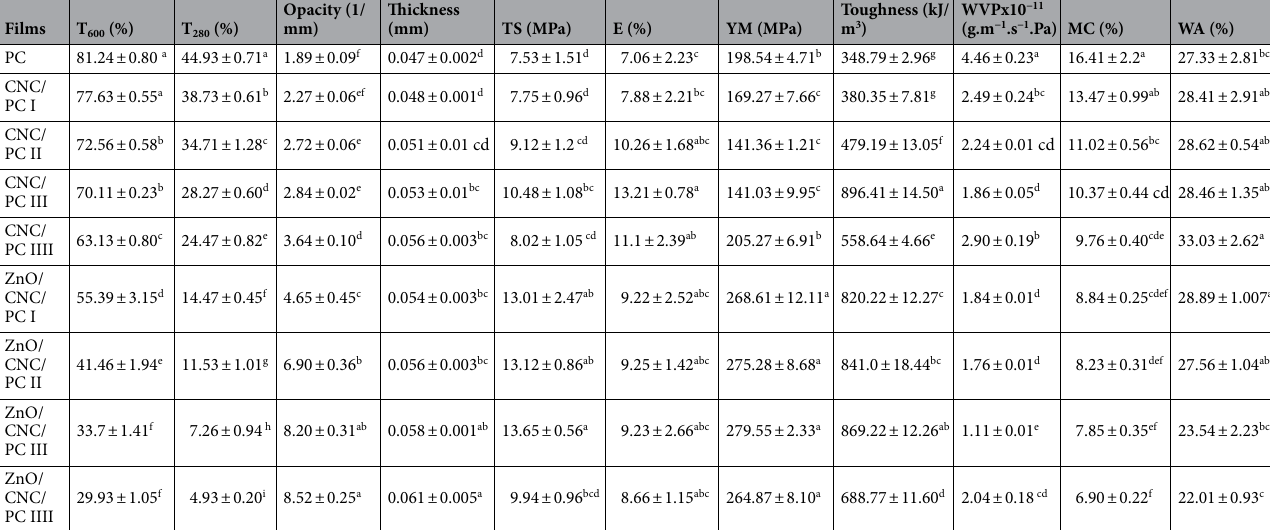
Table 2. Optical, mechanical, barrier and physicochemical characteristics of the films. Values are presented as means ± SD ( n = 3) from at least two independent experiments. Different superscript letters within the same column indicate significant differences ( p < 0.05). The different superscript letters (a–g) within the same column indicate statistically different